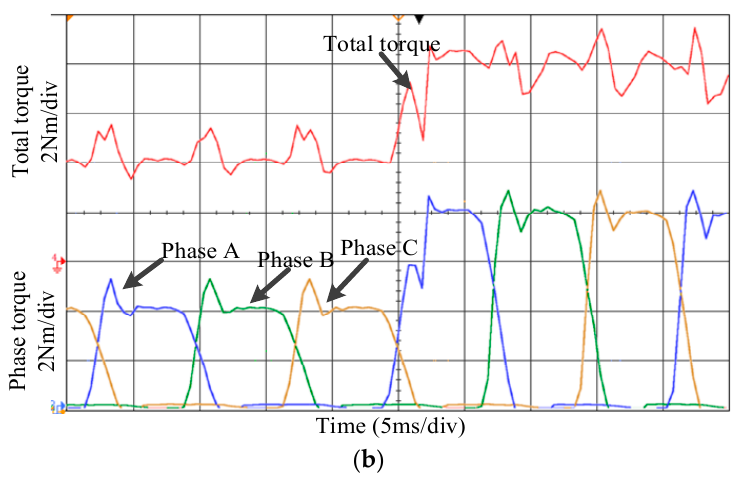
Figure 18. Experiment results with current predictive control based on cube TSF at 100 r/min. ( a ) Current profile ( b ) Phase torque and total torque profiles.